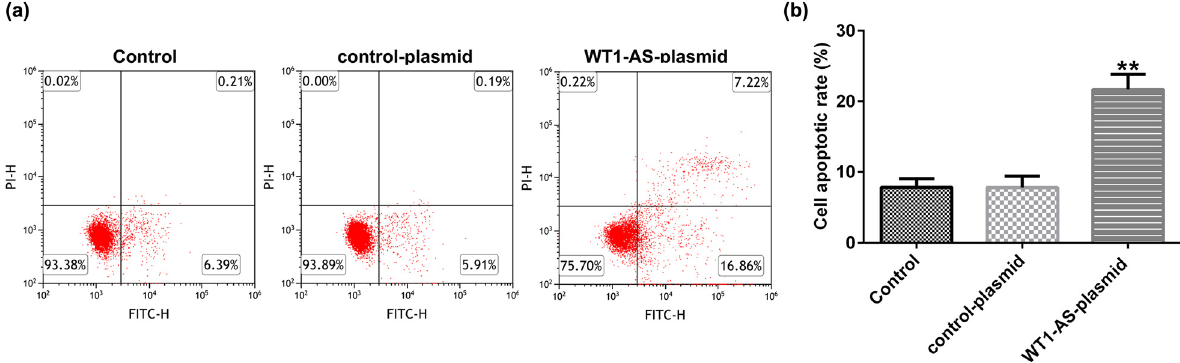
Figure 2: E ff ects of WT1 - AS plasmid on apoptosis of HTR - 8/SVneo cells. ( a and b ) Flow cytometry analysis of apoptotic HTR - 8/SVneo cells. ** P <